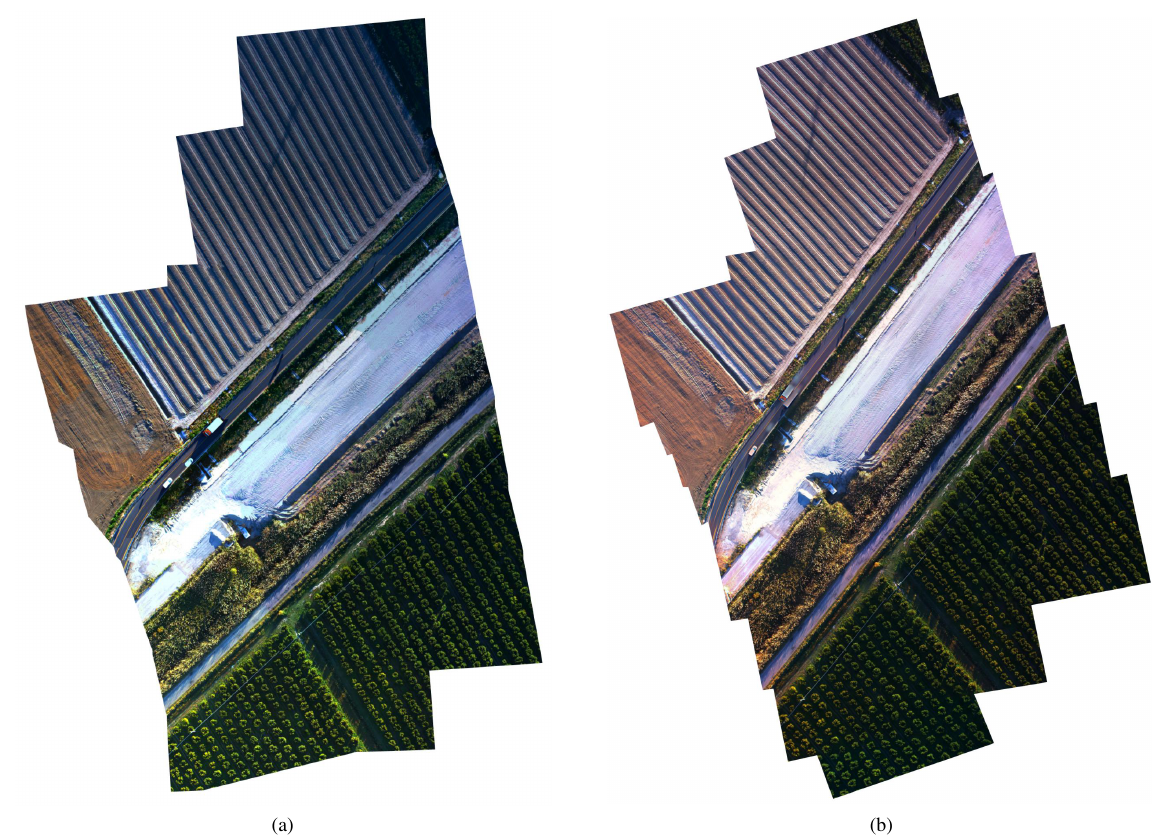
Figure 8. Dataset 1. (a) Mosaic obtained with the proposed method. (b) Mosaic obtained with AutoStitch .